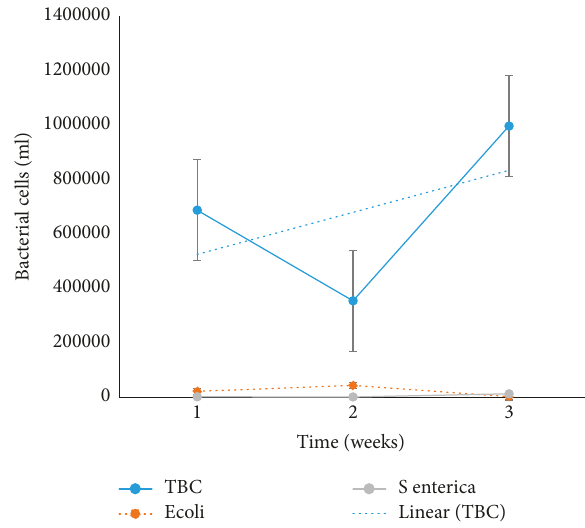
Figure 1: TBC, E coli , and S enterica cells from raw